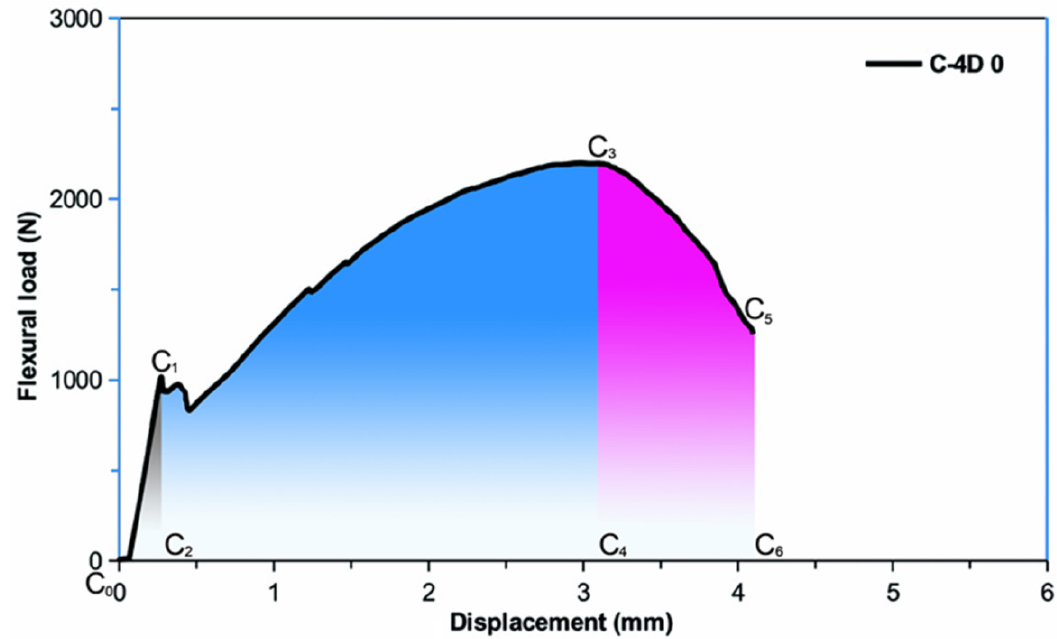
Figure 13. Presentation of the representative areas under the load-deflection curves of the multiaxis 3D carbon fiber concrete to calculate various flexural energies.